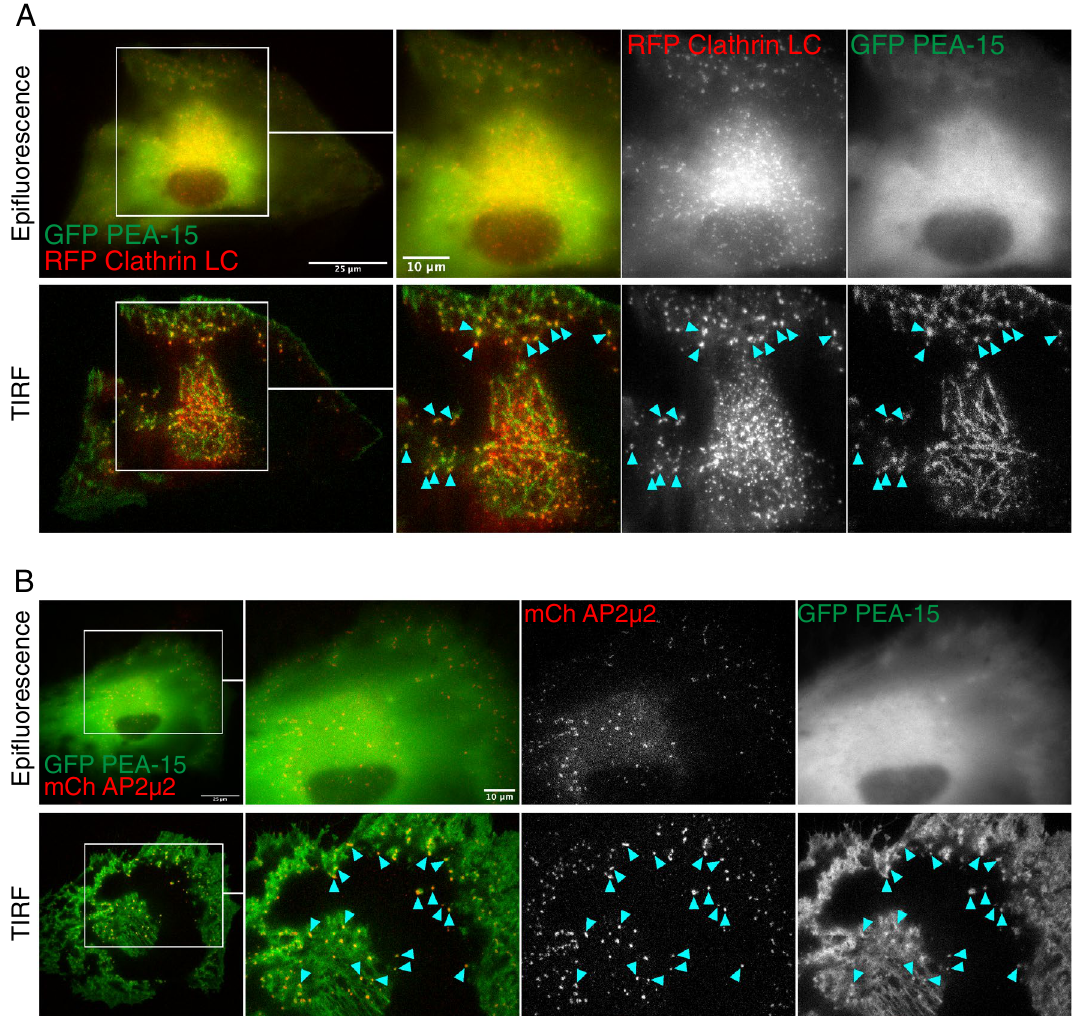
Figure 2. PEA-15 is localized to Clathrin and AP-2 at the plasma membrane. ( A ) GFP-tagged PEA-15 and RFP-tagged Clathrin light chain were co-expressed in U87MG cells and observed under both epifluorescent and TIRF (Total Internal Reflection Fluorescence) imaging. ( B ) Images were acquired as in part A, but instead with GFP-PEA15 coexpressed with mCherry-tagged AP2µ2. Blue arrows indicate sites of colocalization at the cell surface resolved in TIRF. Scale bar in zoomed-out images = 25 µm. Scale bar in zoomed-in images = 10 µm